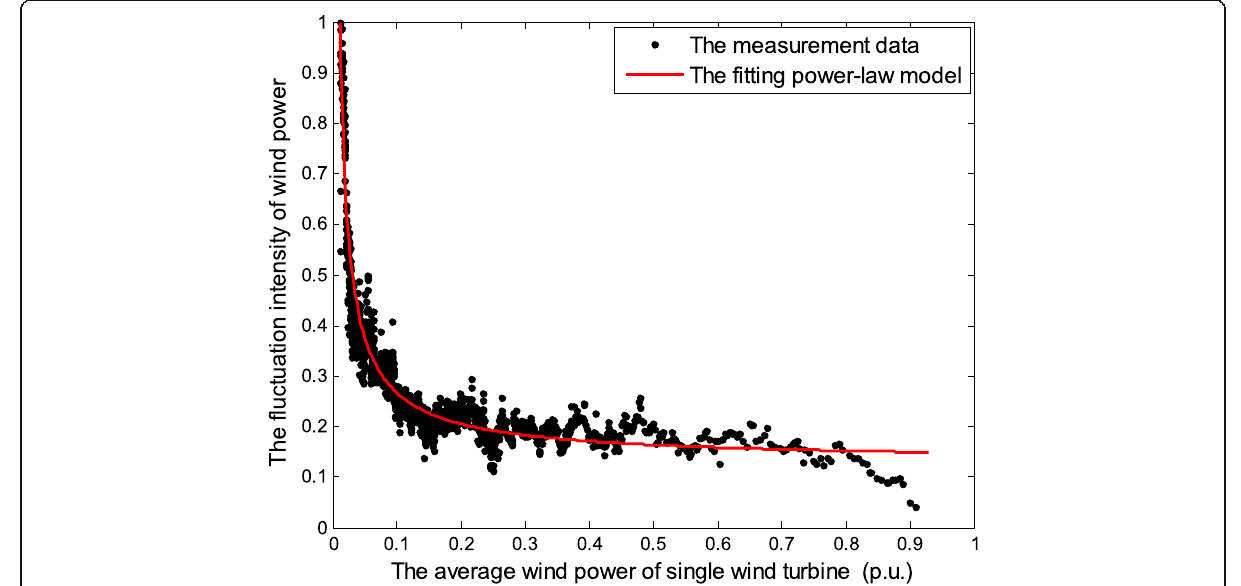
Fig. 5 Relationship between wind power uncertainty and the average value